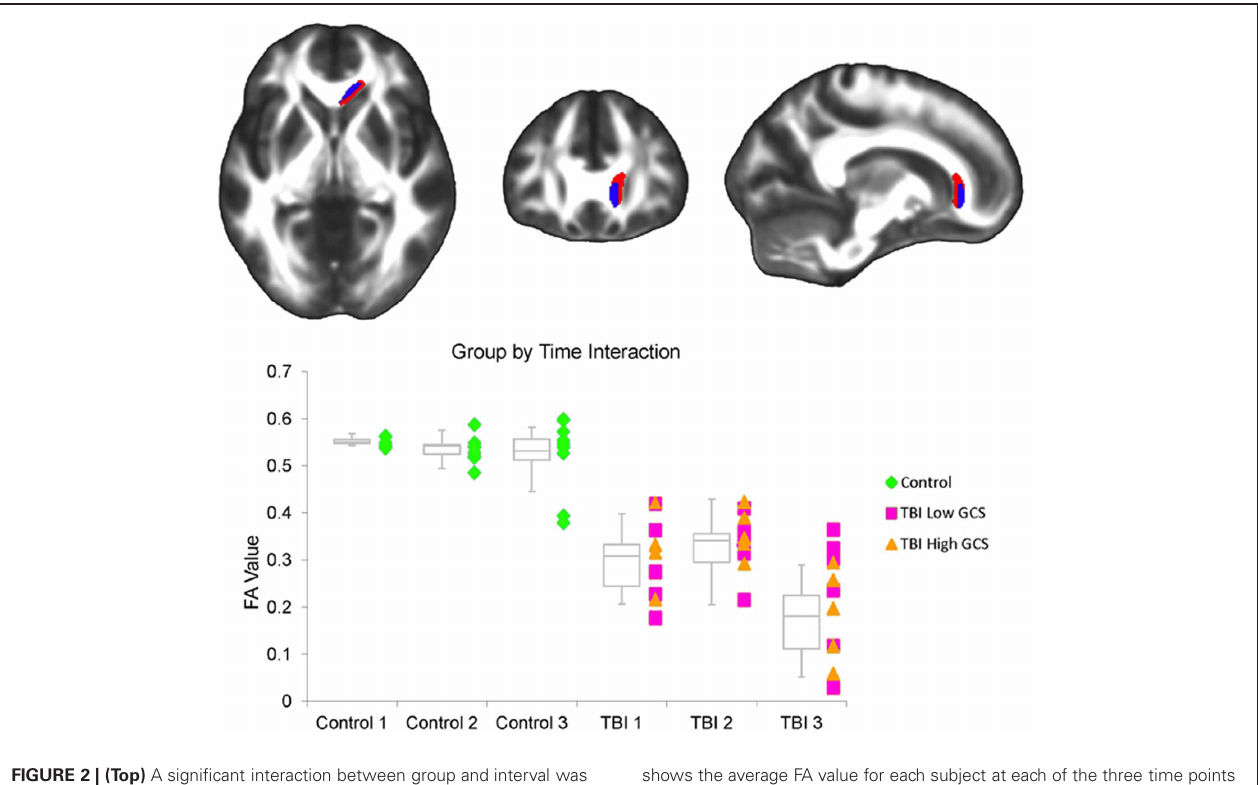
FIGURE 2 | (Top) A significant interaction between group and interval was observed within the FA factorial model. There were inter-interval dissimilarities in group-wise patterns of FA change in the genu of the corpus callosum (red). Axial and radial diffusivity analyses were restricted to regions demonstrating an FA effect. Within this region, a significant interaction was also observed in the radial diffusivity factorial model (overlapping blue region), but not the axial diffusivity factorial model. The left side of the statistical map is patient left and right is patient right. ( Bottom ) This graph